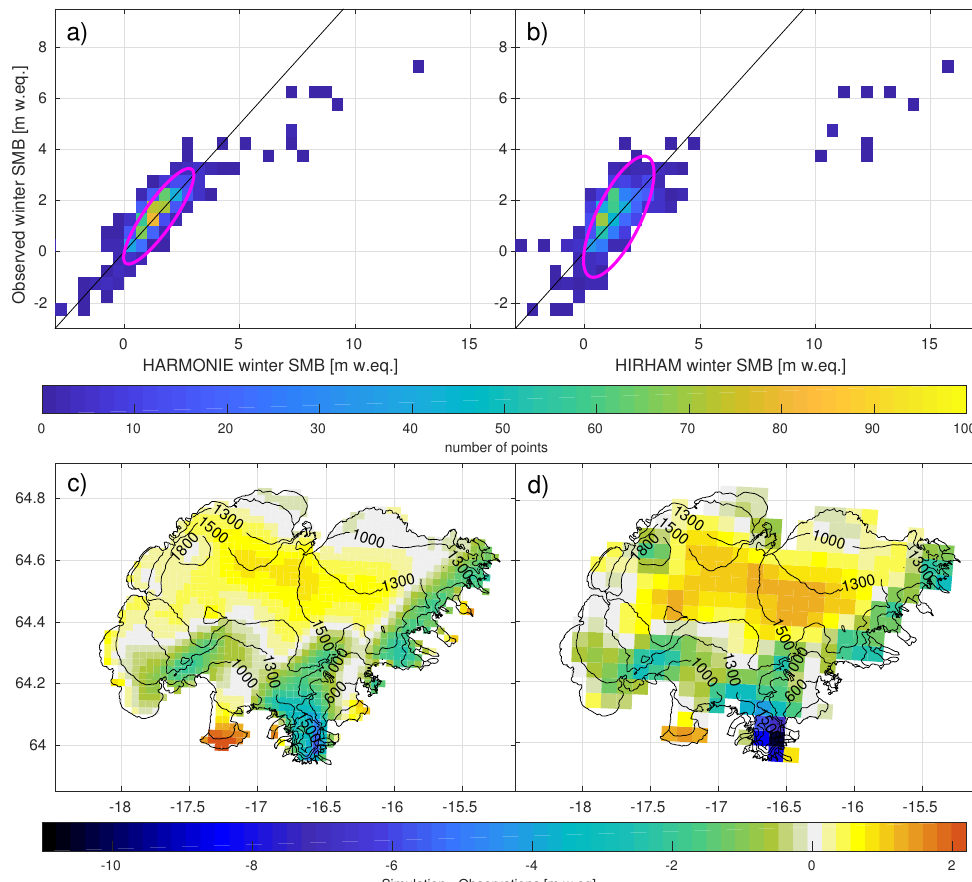
Figure 3. ( a ) HARMONIE and ( b ) HIRHAM5 winter mass balance compared to measurements from 1992 to 2014. Color bar shows how many points are in the same spot and purple ellipsis outlines 68% of the points. Statistics on the regression lines are given in Table 1. Interpolated observed mean winter mass balance maps from 1992 to 2014 compared to ( c ) HARMONIE and ( d ) HIRHAM5 winter mass